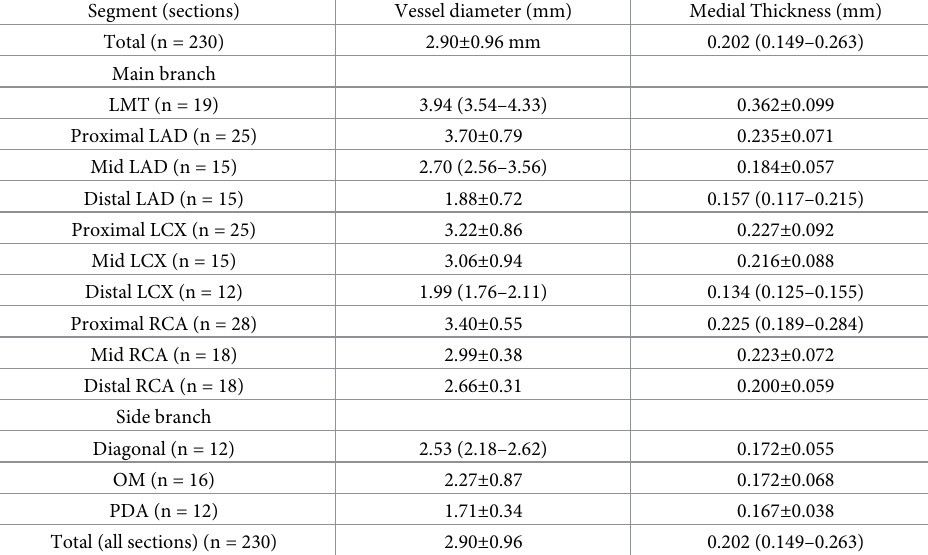
Table 2. Measurements of the vessel diameter and the medial thickness.